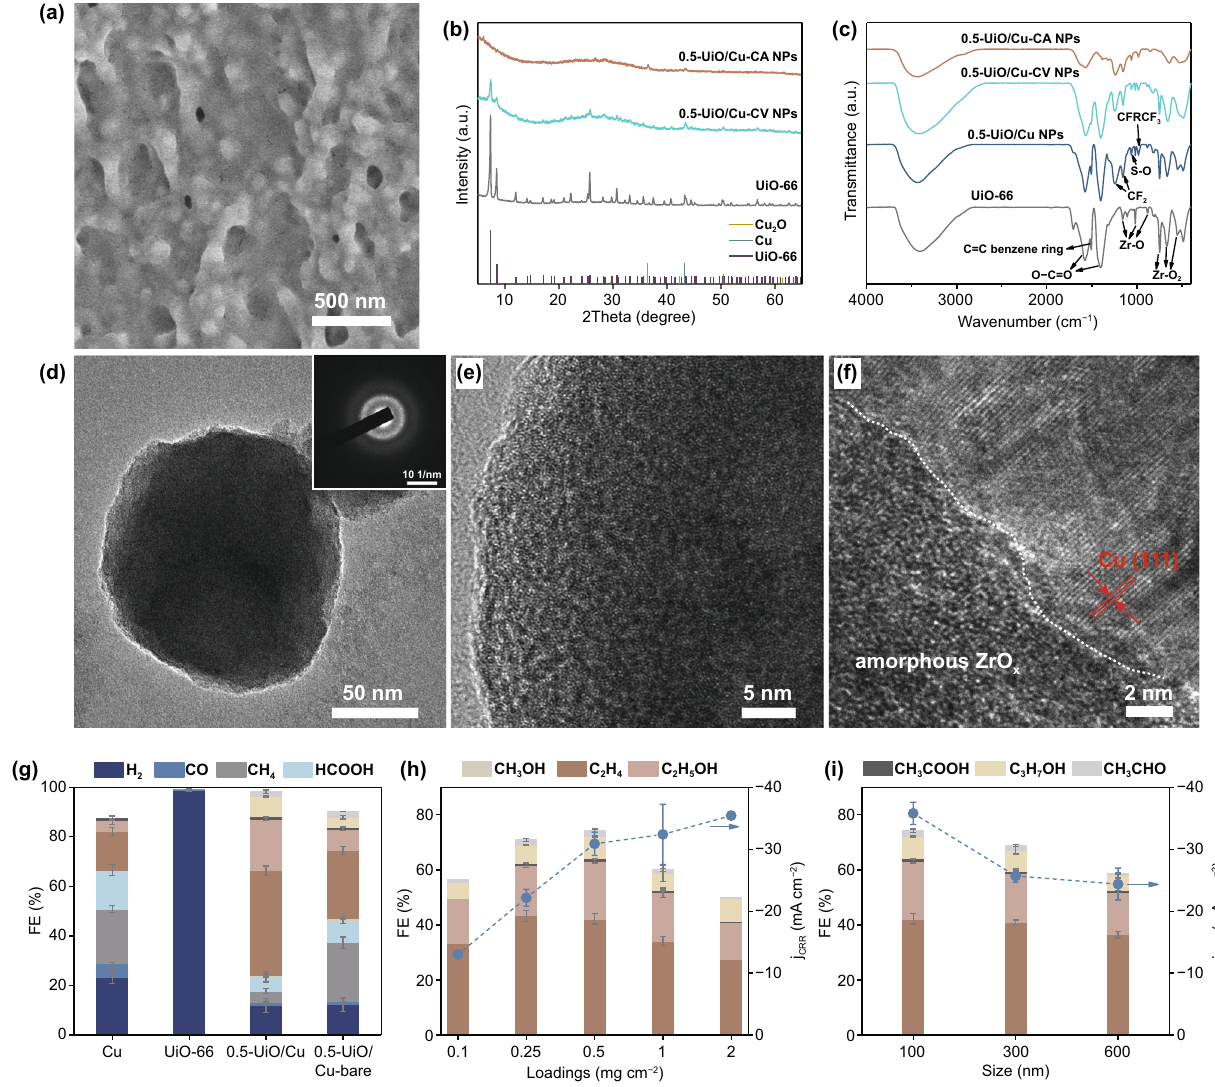
Fig. 3 a Top-view SEM image of 0.5-UiO/Cu after CO 2 RR at − 1.05 V versus RHE for 1 h. b XRD patterns and c FT-IR spectra of UiO-66, 0.5-UiO/Cu NPs, 0.5-UiO/Cu-CV NPs, and 0.5-UiO/Cu-CA NPs. d TEM image of 0.5-UiO/Cu-CA NPs (inset: the corresponding SAED pat- tern). e HRTEM image of 0.5-UiO/Cu-CA NPs. f HR-TEM image of interface structure of 0.5-UiO/Cu after CO 2 RR at − 1.05 V versus RHE for 1 h. The product distribution of HER and CO 2 RR g on Cu, UiO-66, 0.5-UiO/Cu and 0.5-UiO/Cu-bare electrodes, h on X-UiO/Cu